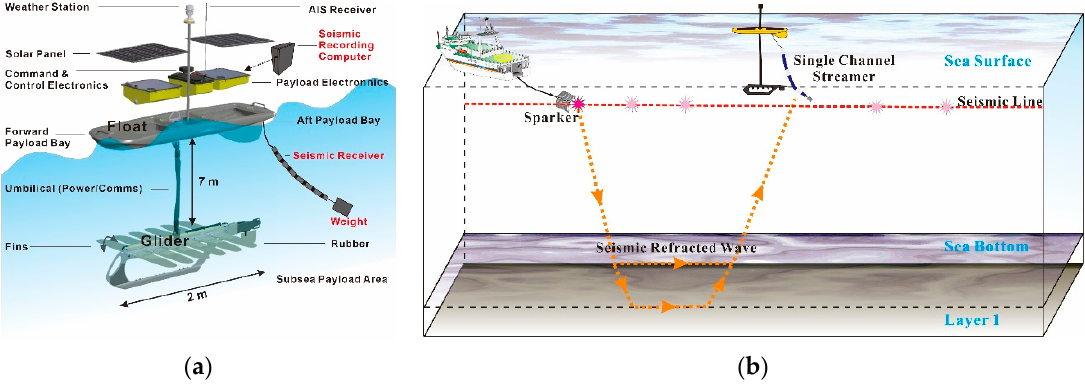
Figure 1. Equipment used in the seismic refraction survey: ( a ) diagram of the wave glider (modified from [7]) and ( b ) schematic of the artificial sound source and receiver (sparker and streamer, respectively).